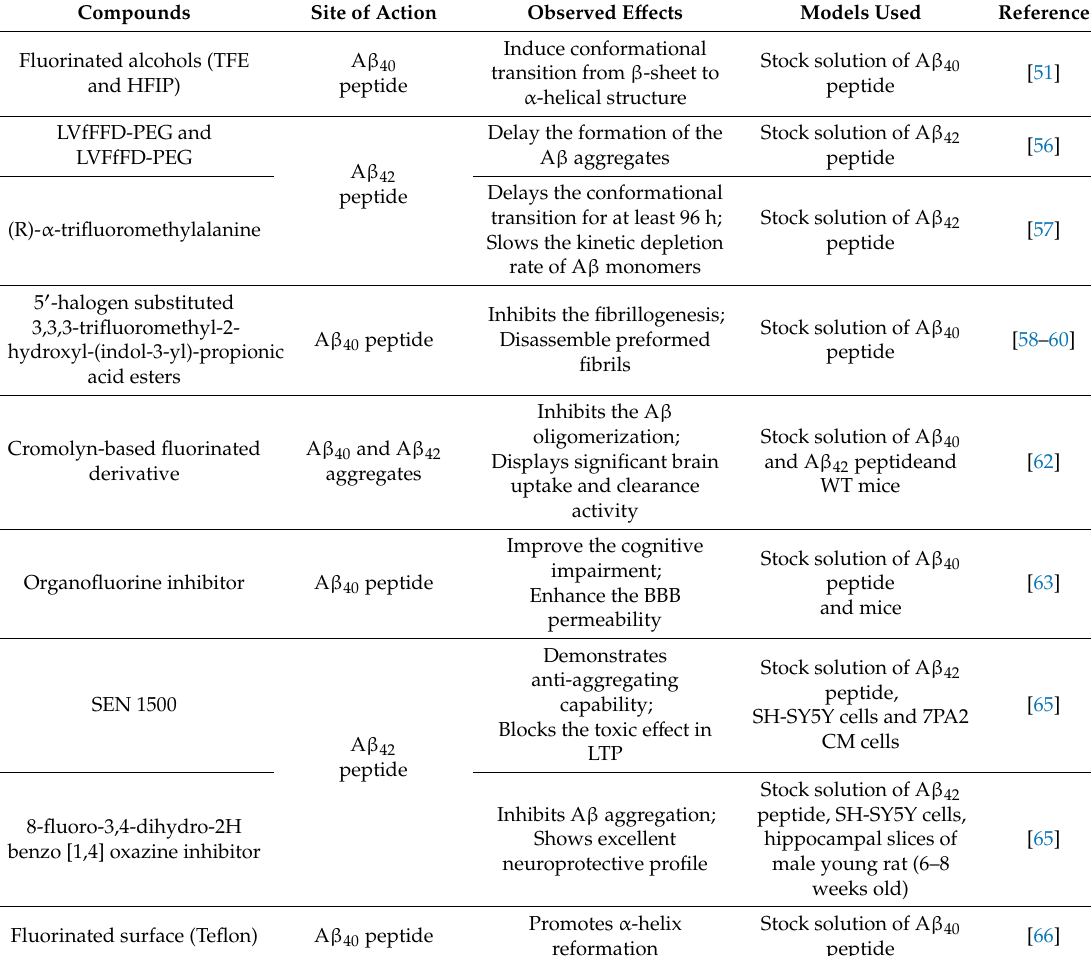
Table 1. Fluorinated molecules and surfaces developed for the inhibition of amyloid-beta